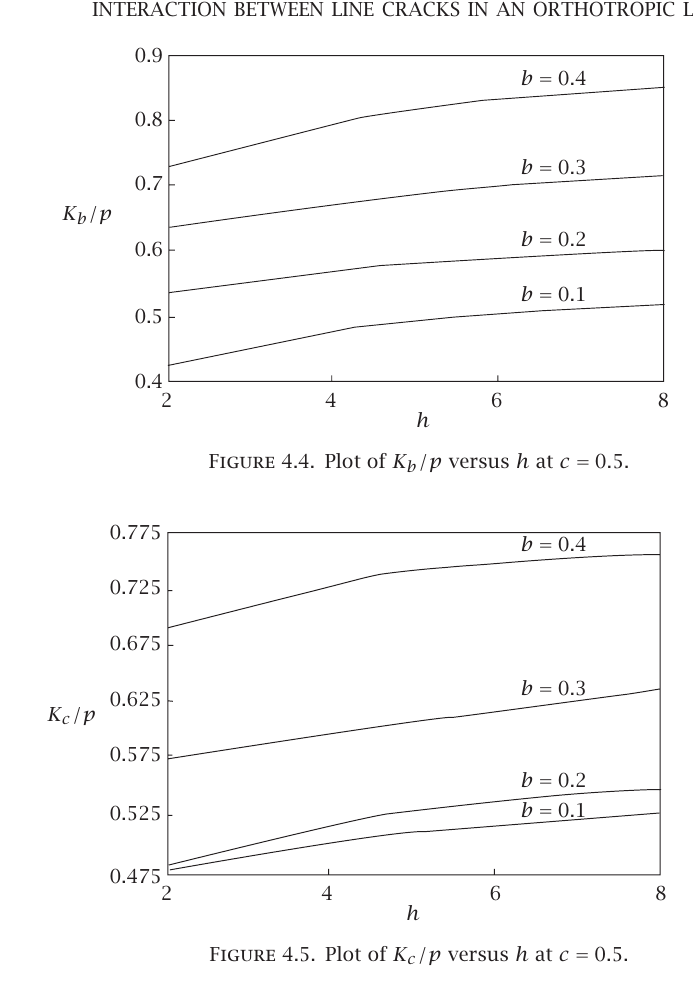
Figure 4.5 . Plot of K c /p versus h at c = 0 . 5.